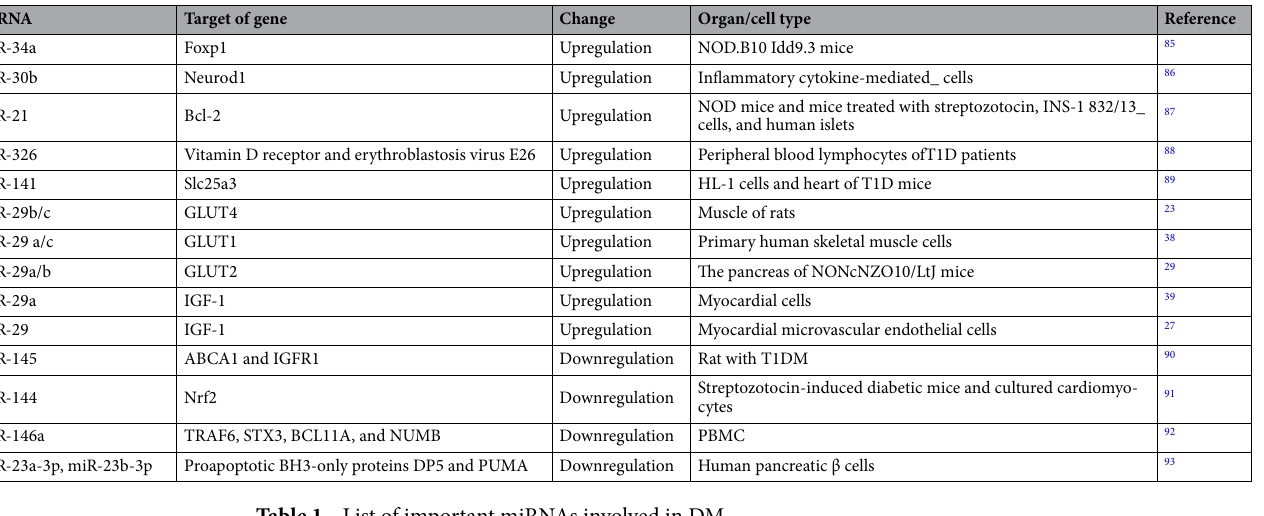
Table 1. List of important miRNAs involved in